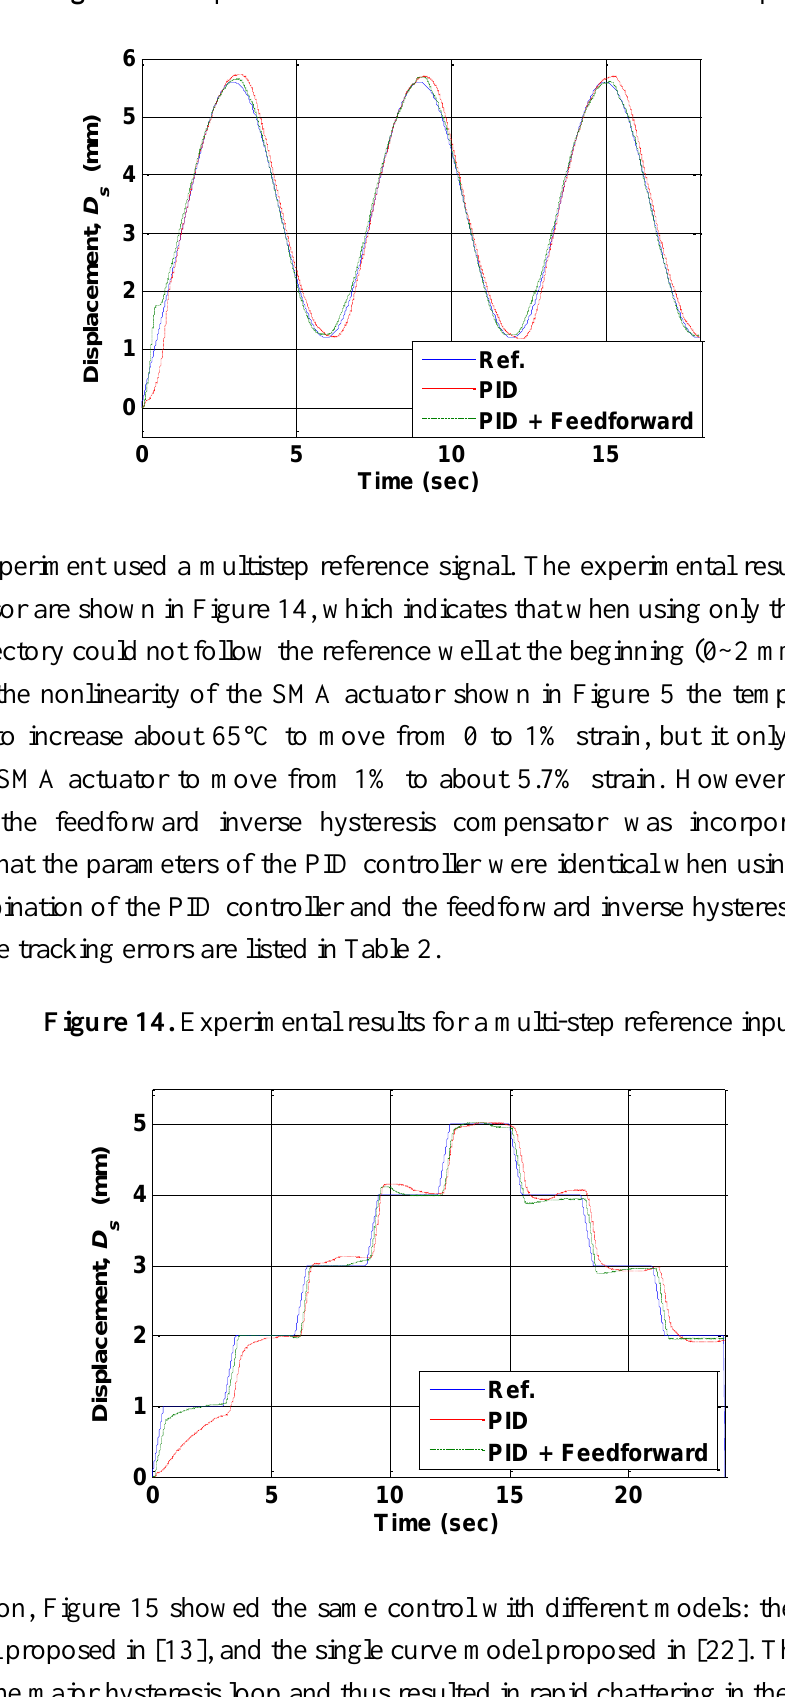
Figure 13. Experimental results for a sinusoidal reference input.